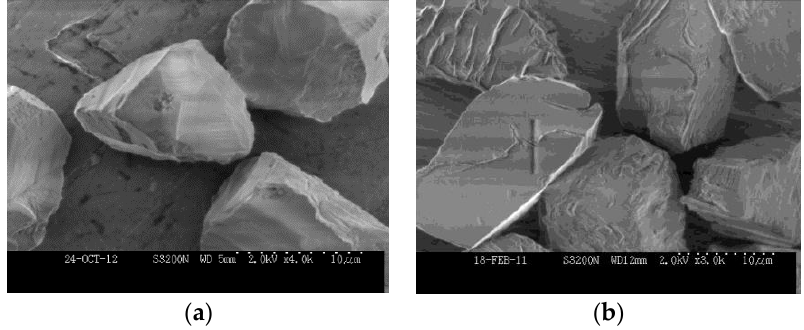
Figure 1. Scanning electronic micrographs of ( a ) the regular monocrystalline diamond grains and ( b ) the surface textured monocrystalline diamond grains.